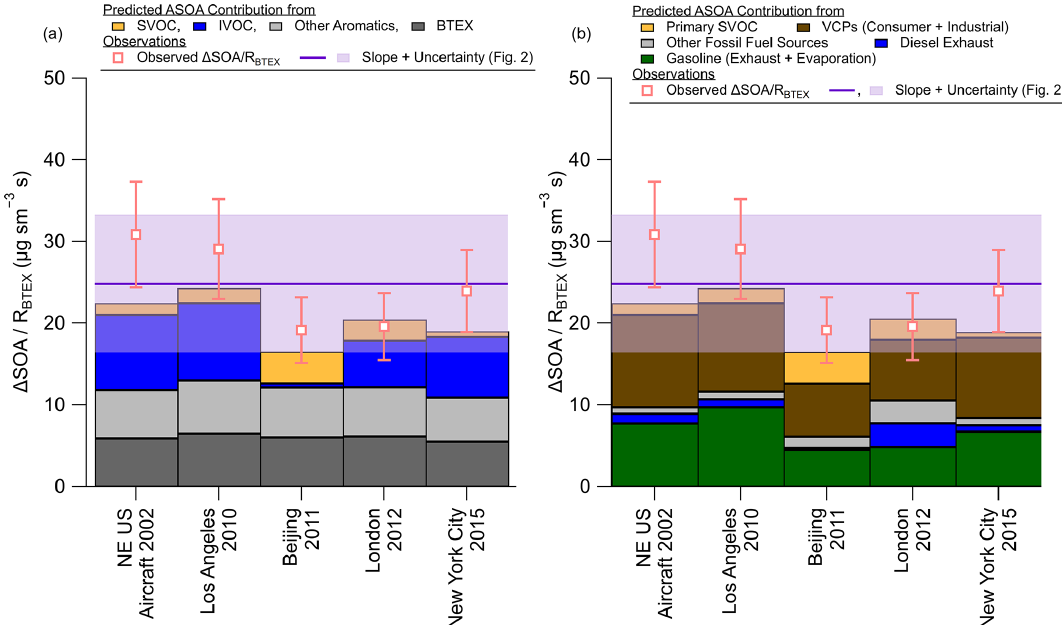
Figure 4. (a) Budget analysis for the contribution of the observed (cid:49) SOA /R BTEX (Fig. 2) for cities with known emissions inventories for different volatility classes (see Fig. 5 and Fig. S6 in the Supplement). Panel (b) is the same as panel (a) but for sources of emissions. For panels (a) and (b) , SVOC is the contribution from both vehicle and other (cooking, etc.) sources. See the Supplement for information about the emissions, ASOA precursor contribution, error analysis, and a discussion about the sensitivity of emission inventory IVOC/BTEX ratios for different cities and years in the